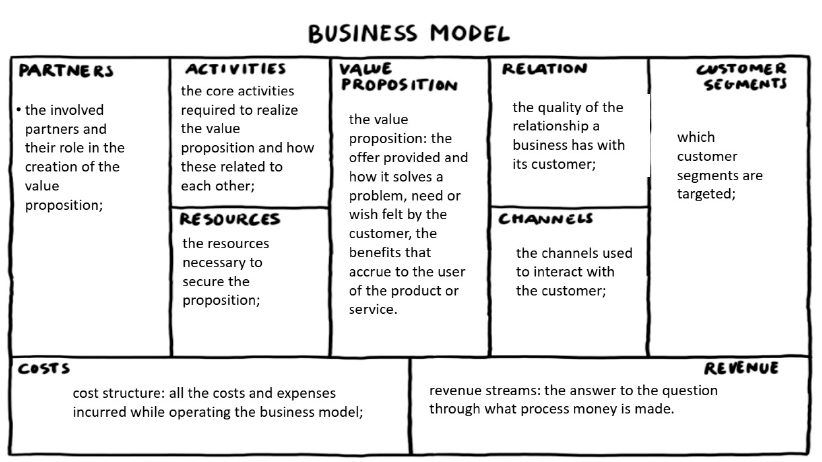
Figure 1. Business Model Canvas